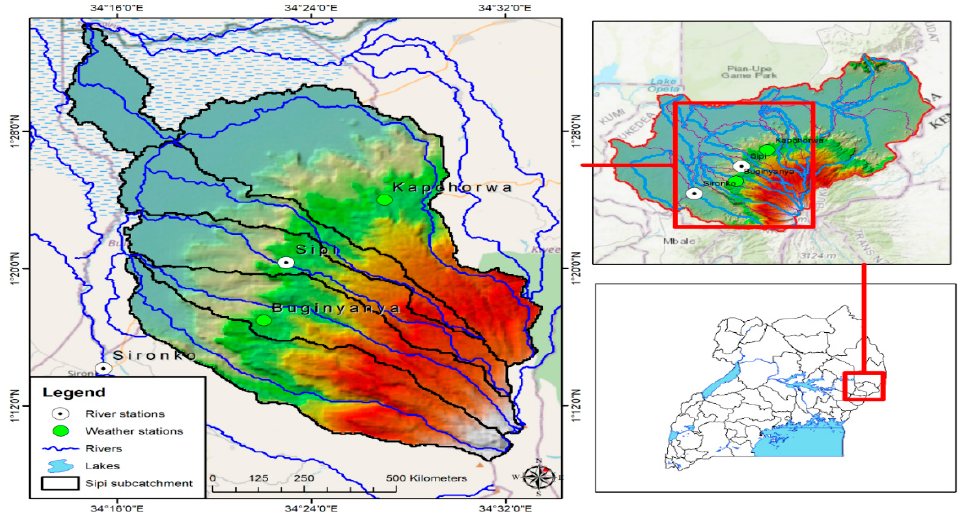
Figure 1. Map of Sipi sub-catchment on the slopes of Mt. Elgon, Uganda.